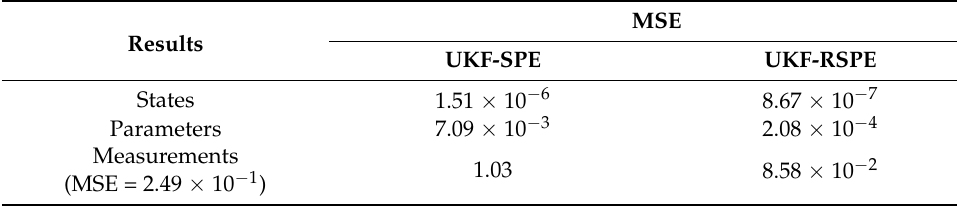
Table 5. Statistical information of the estimated results in Case Study